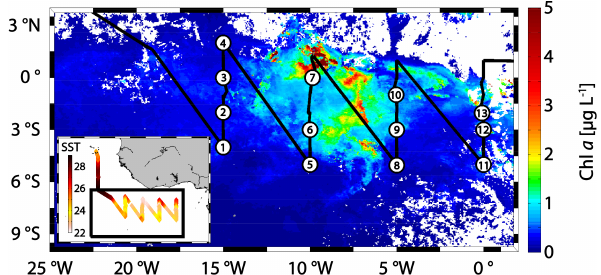
Figure 1. Cruise track with SST in ◦ C (small box) and the section (large box) where halocarbons were sampled in both the sea surface and during CTD stations (numbered circles), plotted on monthly average Chl a for July 2011 derived from mapped level 3 MODIS Aqua